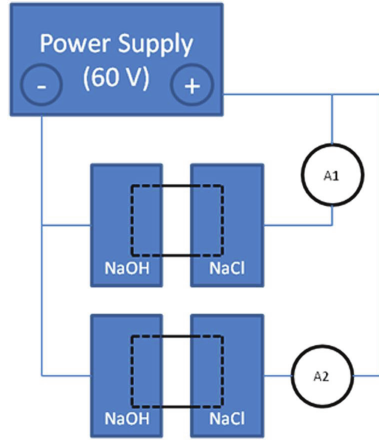
Fig. 1. Schematic of sorptivity test